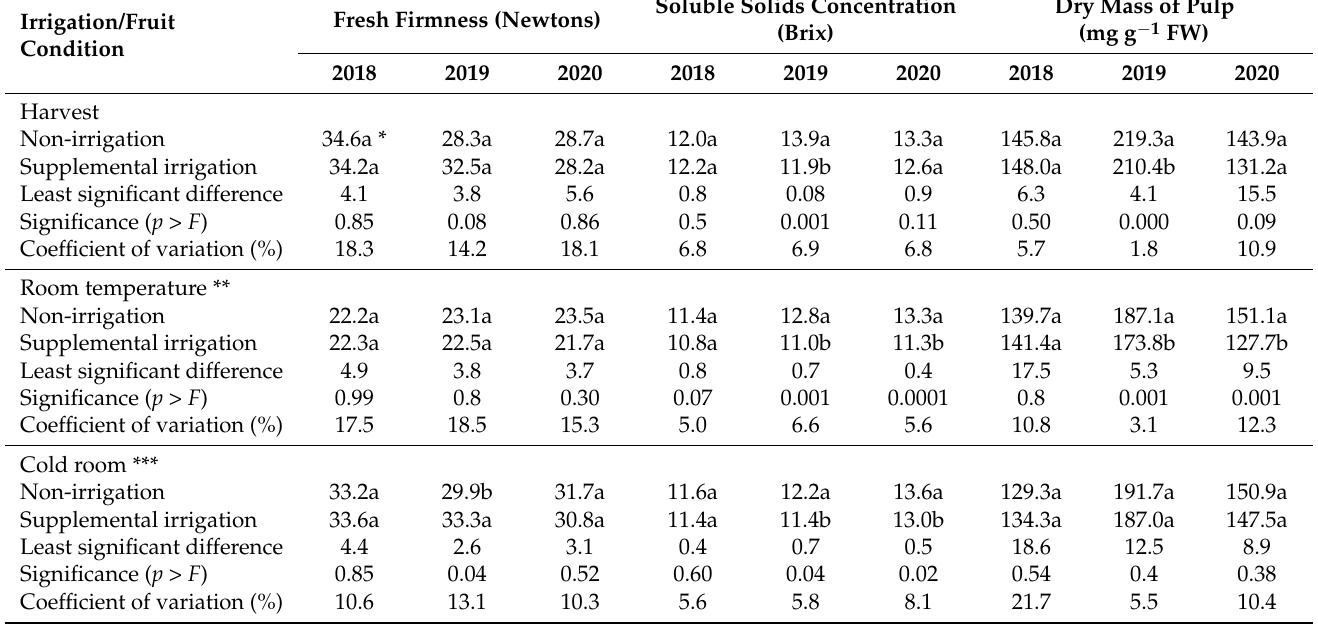
Table 5. Influence of supplemental irrigation on some fruit quality attributes of ‘Roja Lisa’ cactus pear. Fruit were harvested from the commercial orchard ’Las 100 Hect á rias’. La Victoria, Pinos, Zacatecas, Mexico.